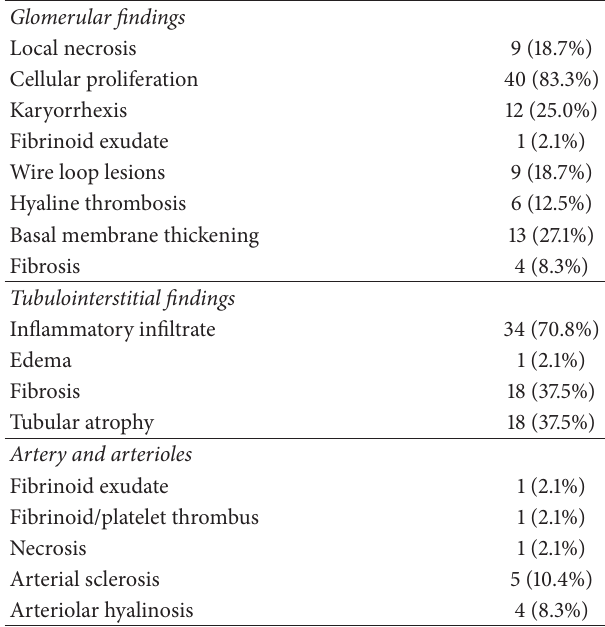
Table 2: Histopathology characteristics in 48 patients with biopsy proven